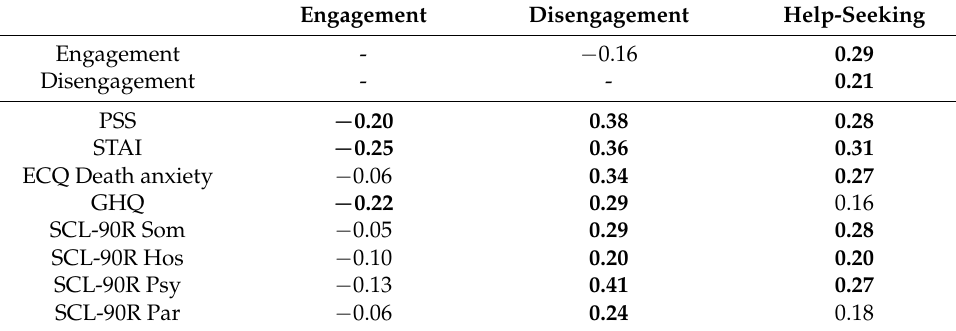
Table 3. Correlation analysis of the three identified coping styles. Engagement Disengagement Help-Seeking Engagement - −